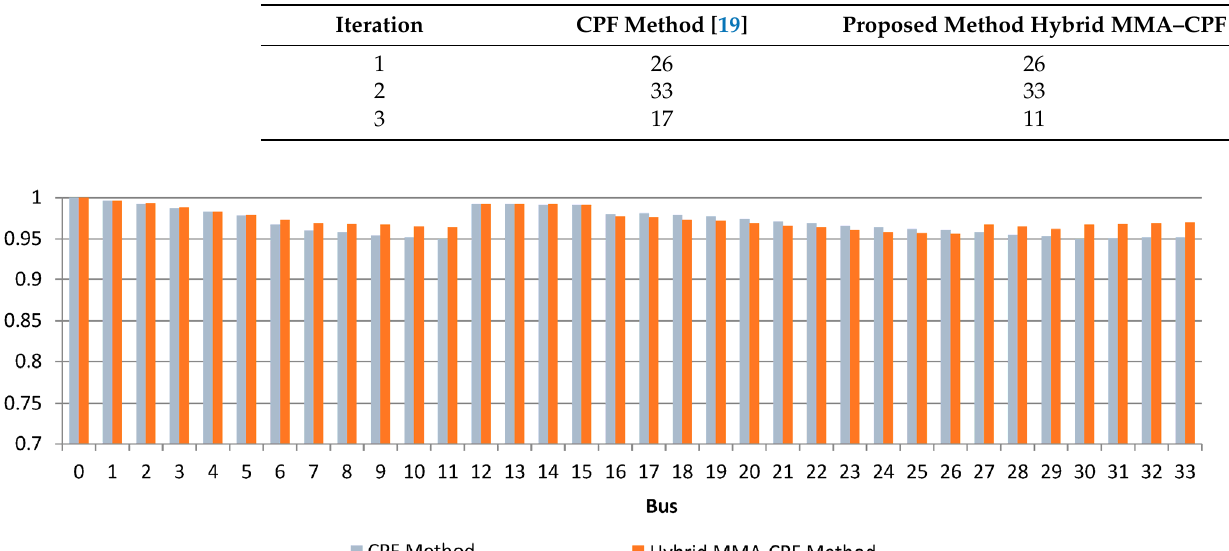
Figure 13. Voltage magnitude after DER integration with the CPF method and the proposed hybrid method.